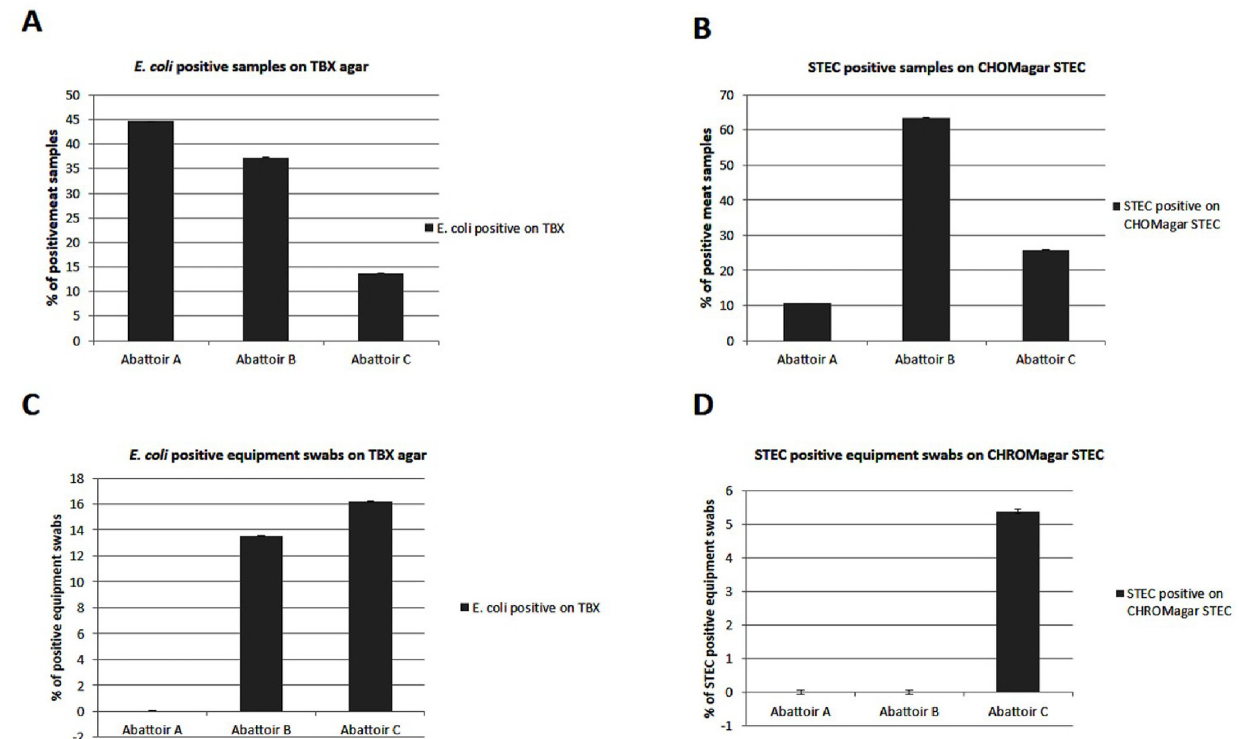
Fig 3. Presumptive E. coli and STEC positive samples based on growth on TBX and CHROMagar. ( A ) Illustrating 44.6% of samples from abattoir A, 37.25% from abattoir B and 13.72% from abattoir C that showed E . coli growth on TBX. ( B ) Illustrating 10.58% of meat samples from abattoir A, 63.53% from abattoir B and 25.88% from abattoir C that showed STEC cultures (mauve) on CHROMagar STEC. ( C ) Indicating the presence of E . coli in 13.51% equipment swabs from abattoir B and 16.21% equipment swabs from abattoir C. ( D ) showing the presence of STEC in 5.40% equipment swabs from abattoir C.